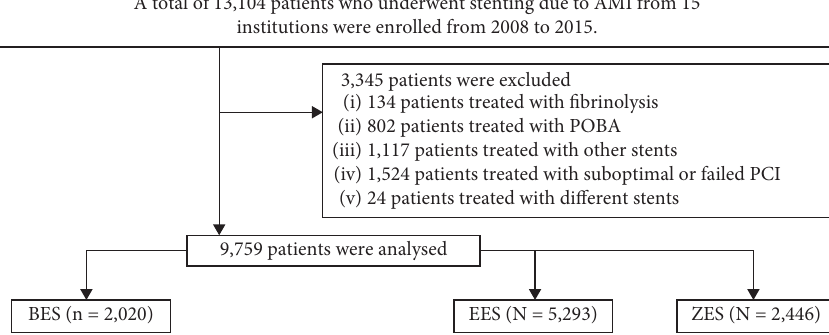
Figure 1: Study population. PCI, percutaneous coronary intervention; POBA, plain old balloon angioplasty; DESs, drug-eluting stents; BES, biolimus-eluting stent; EES, everolimus-eluting stents; ZES, zotarolimus-eluting